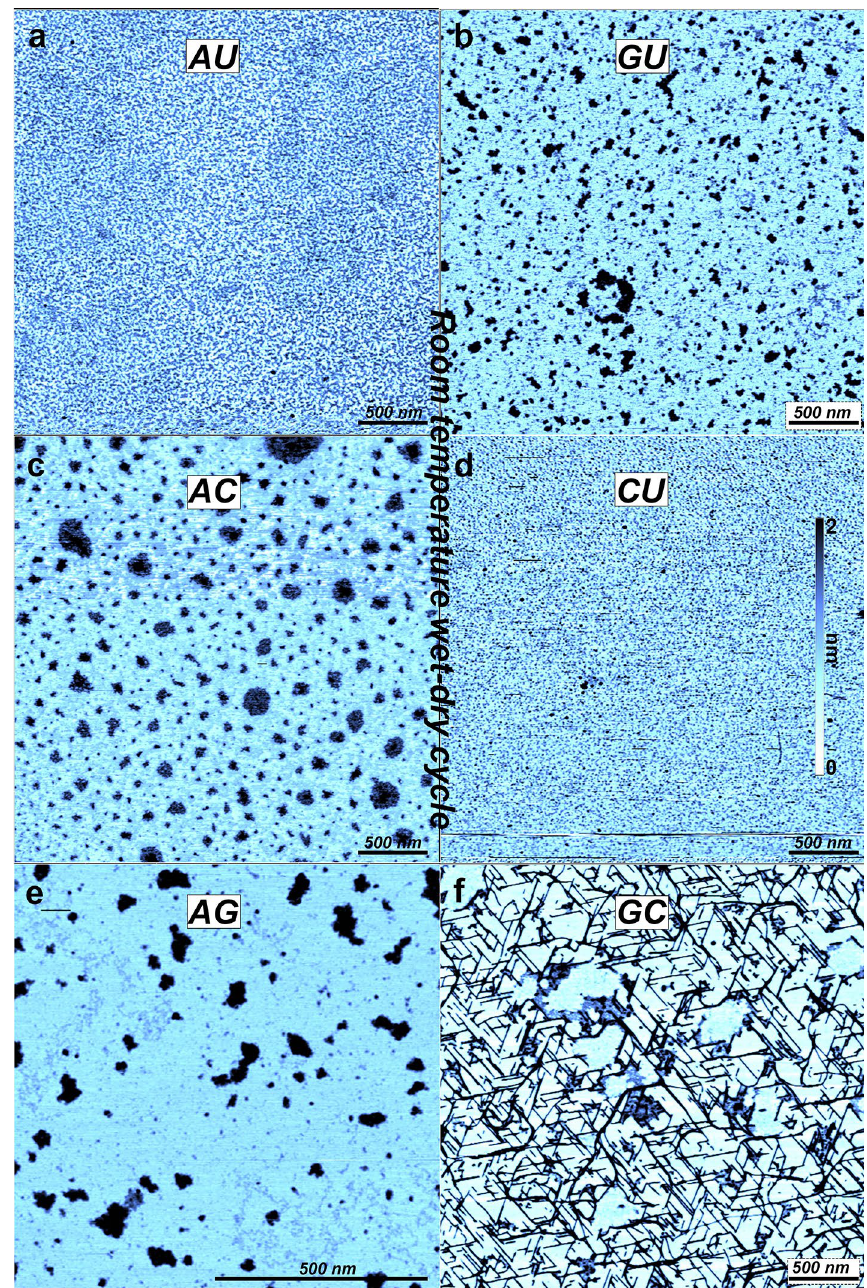
Figure 3. AFM images of 1:1 mixtures of 10 mM mononucleotides which underwent 3 wet-dry cycles on mica surfaces at room temperature. ( a ) AMP + UMP, ( b ) GMP + UMP, ( c ) AMP + CMP, ( d ) CMP + UMP, ( e ) AMP + GMP, ( f ) GMP + CMP. To make the images comparable the color scale covers the range from 0 to 2 nm for all the